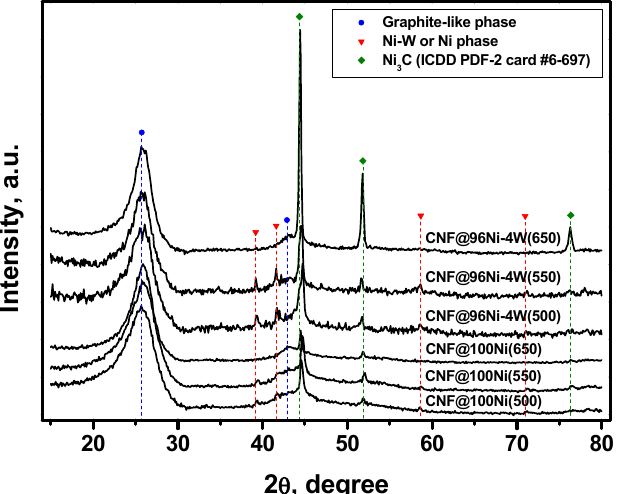
Figure 8. X-ray diffraction profiles for 96Ni–4W alloys and pure 100Ni samples after 2h reaction with TCE (500, 550, and 650 °C).